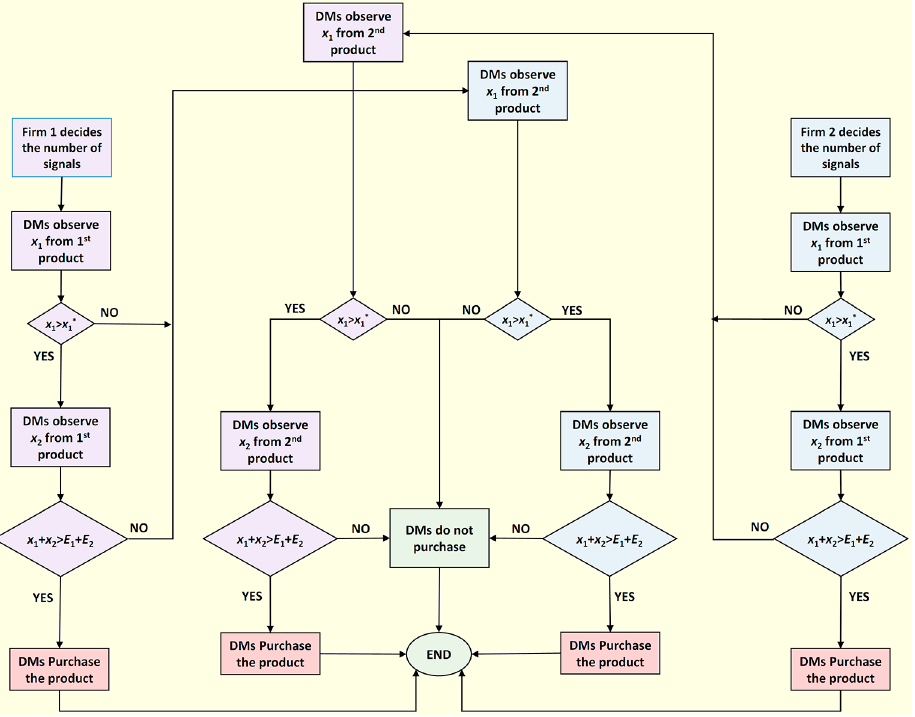
Figure 8. Information acquisition process, purchase decisions and market development